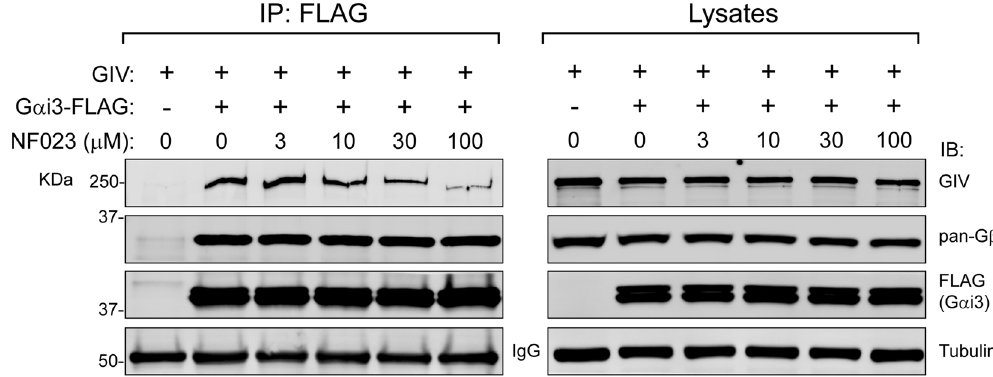
Figure 11. NF023 inhibits GIV but not G βγ co-immunoprecipitation with G α i3. Lysates of HEK293T cells transfected with G α i3-FLAG and full-length GIV as indicated were subjected to immunoprecipitation (IP) with anti-FLAG antibodies in the presence of increasing amounts of NF023 (3–100 µ M). Immunoblots of the immunoprecipitated proteins are shown on the left panels and immunoblots of equal lysate aliquots on the right panels. One experiment representative of three is shown. Imagens of the full membrane strips probed with antibody are shown in Supplementary